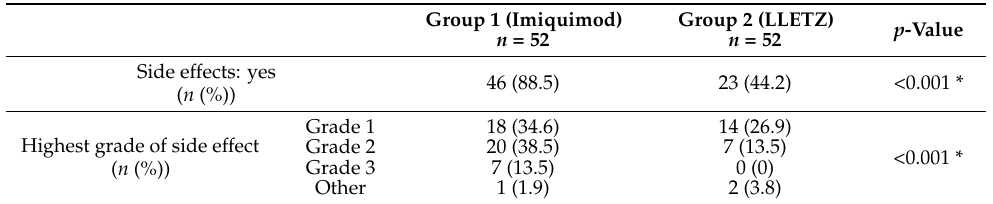
Table 3. Presence of side effects and the highest grade of side effect (using the 5th version of CTCAE guidelines) in patients treated with imiquimod (Group 1) and LLETZ (Group 2).